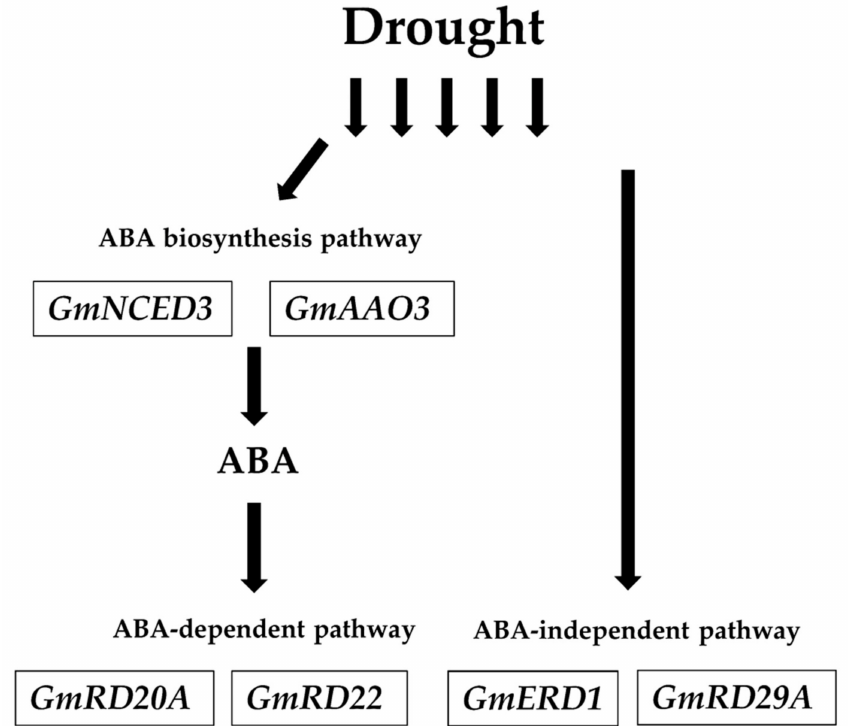
Figure 6. Regulation of genes in ABA-dependent and ABA-independent pathways in response to drought stress in edamame. Different cultivars exhibited different expression patterns in these drought- related genes. Genes in both ABA-dependent and ABA-independent pathways were significantly upregulated in KH11 by drought stress. AAO, abscisic aldehyde oxidase. ERD, early responsive to dehydration. NCED, 9 (cid:48) - cis -epoxycarotenoid dioxygenase. RD, responsive to dehydration. Taken together, our results indicated that XJ and KH11 exhibited similar patterns in yield data and that they were less affected by drought stress than KH9, probably because they are close relatives. Under normal conditions, KH9 and KH11 produce higher yields than XJ; however, under drought conditions, KH11 might be a good choice for farmers. The characteristics of cultivars varied considerably. Our data can guide farmers in their planting considerations, and our results on ABA signaling and drought tolerance can also provide basic information for further research by scientists or breeders.